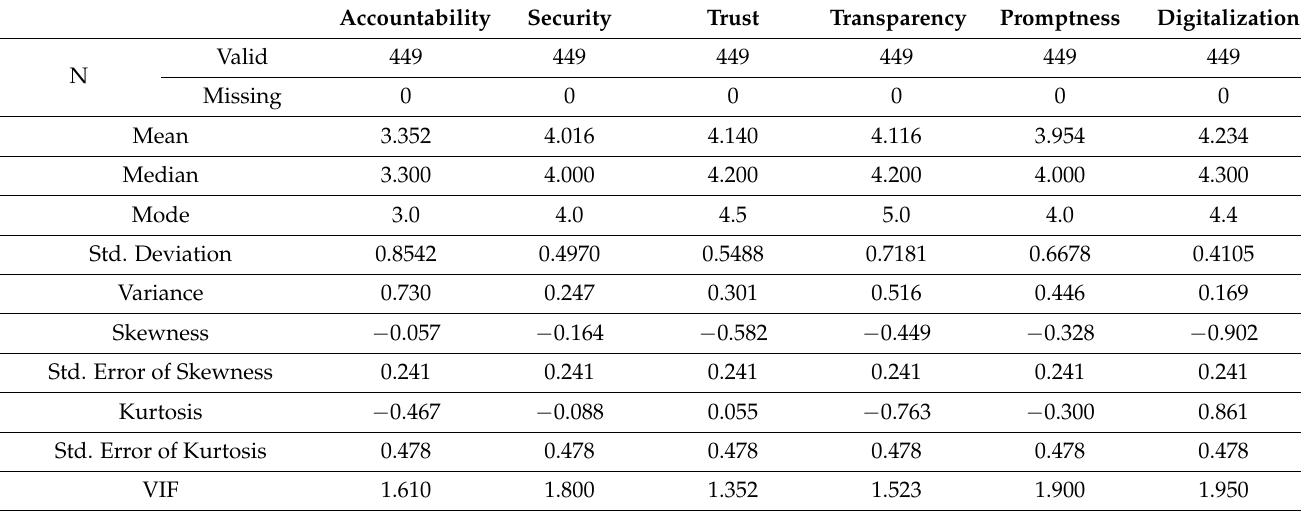
Table 1. Descriptive and Collinearity (VIF) Statistics.